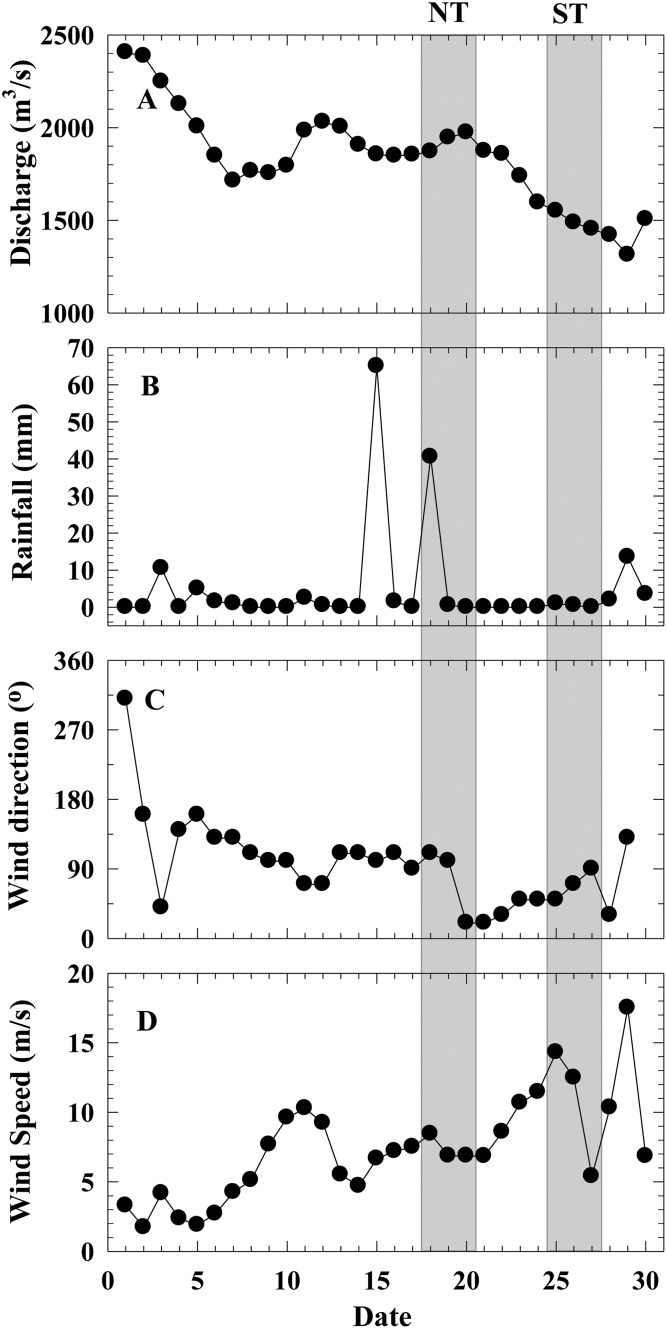
Daily discharge (A), total rainfall (B), average wind direction (C) and wind speed (D) during September 2011.The lighter gray areas indicate sampling period during neap tide (NT, the same below) on Sep 18–20, and spring tide (ST, the same below) on Sep 25–27.